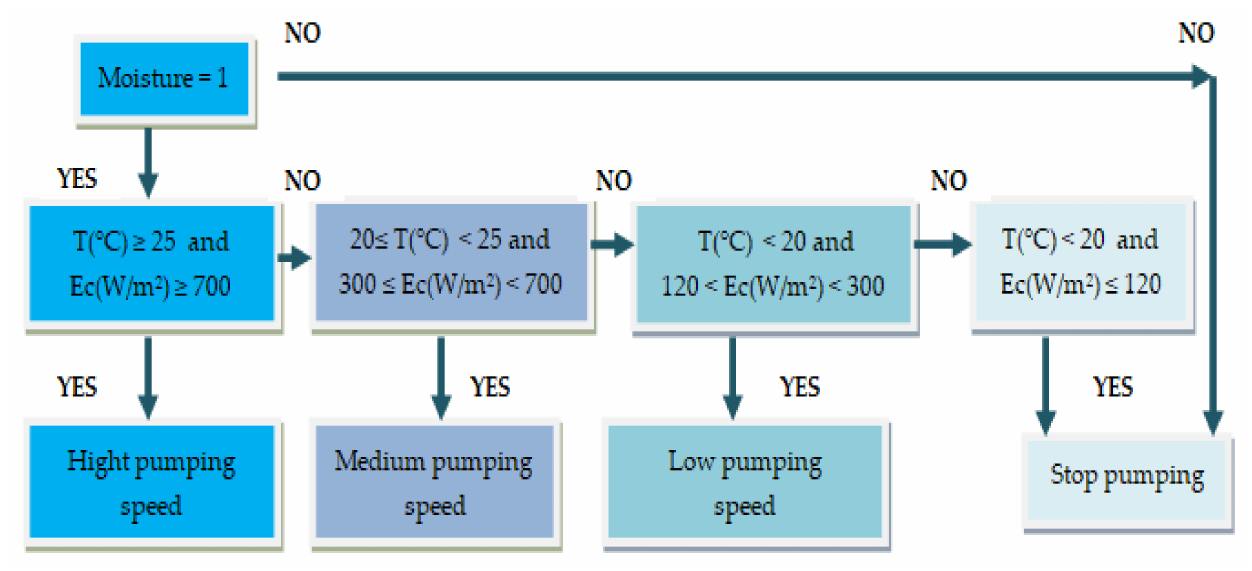
Figure 22. Software algorithm.